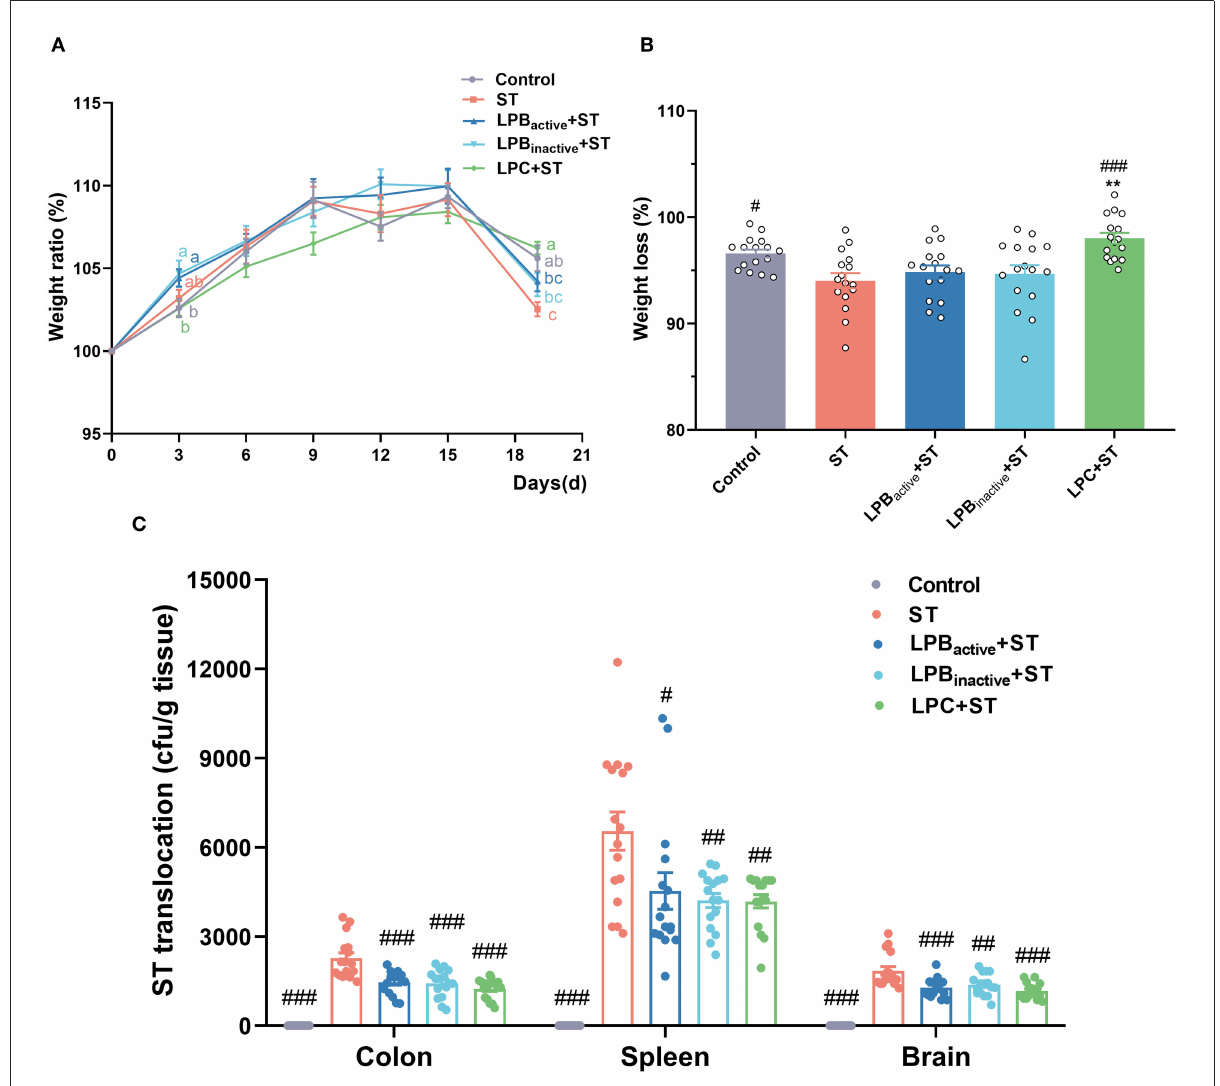
FIGURE2 The LP postbiotics prevent ST infection in mice. (A) weight gain. The body weight of each mouse was measured every 3 days. Weight ratio was calculated as (body weight on day N)/(body weight on day 0) × 100% (B) Weight loss was calculated as (weight on day 19/weight on day 15) × 100%. (C) Salmonella translocation. S almonella translocation in the colon, spleen, and brain were detected using agar plate method, and the number of bacteria was calculated by per gram tissue. The data shown as mean ± SEM were analyzed using one-way ANOVA and Tukey’s test ( N = 16 in each group). Different letters (a, b, and c) represent significant ( p < 0.05) and the color of letters represent the group with the same color. # Indicates the significance compared to ST group: # p < 0.05, ## p < 0.01, ### p < 0.001. * Indicates the significance compared to LPB active + ST group: ** p <